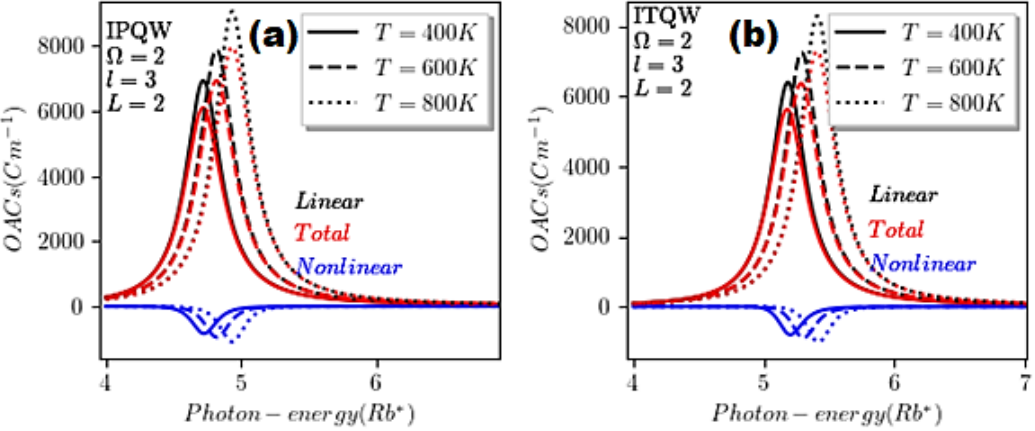
Figure 7: The OACs change versus incident photon energy (R*) with fixed barriers/well widths (L=2; l=3) and x =0.2 (Ω=2) for three different values of temperature T=400K (600K; 800K) max considering two potential shapes IPQW (a) and ITQW